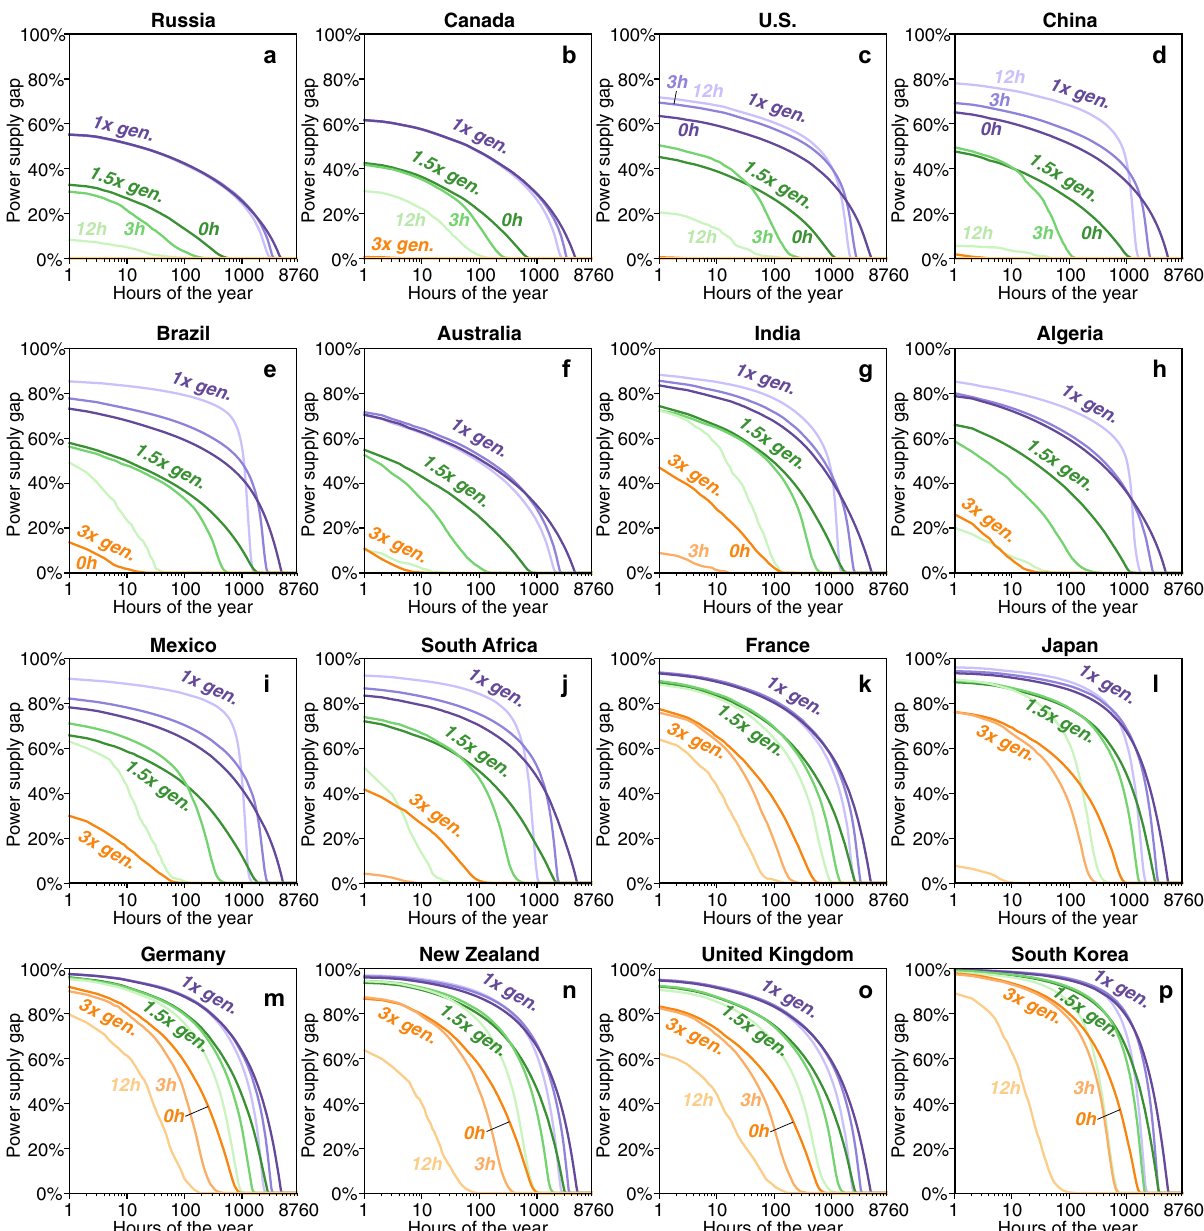
Fig. 4 Average power supply gaps. Areas under each curve show the share and hours of unmet electricity demand of the most reliable solar-wind systems in selected countries assuming speci fi ed storage and generation quantities: a Russia; b Canada; c contiguous U.S.; d China; e Brazil; f Australia; g India; h Algeria; i Mexico; j South Africa; k France; l Japan; m Germany; n New Zealand; o United Kingdom; p South Korea (see data in Supplementary Data 6). Color of lines represents different generation quantities: 1x generation in purple, 1.5x generation in green, and 3x generation in orange. Shading of lines represents different storage quantities: darkest shading represents without storage, medium shading represents 3 h of storage, and lightest shading represents 12 h of storage. Note that the y-axis of power supply gap represents the fraction of unmet demand to the total demand in that